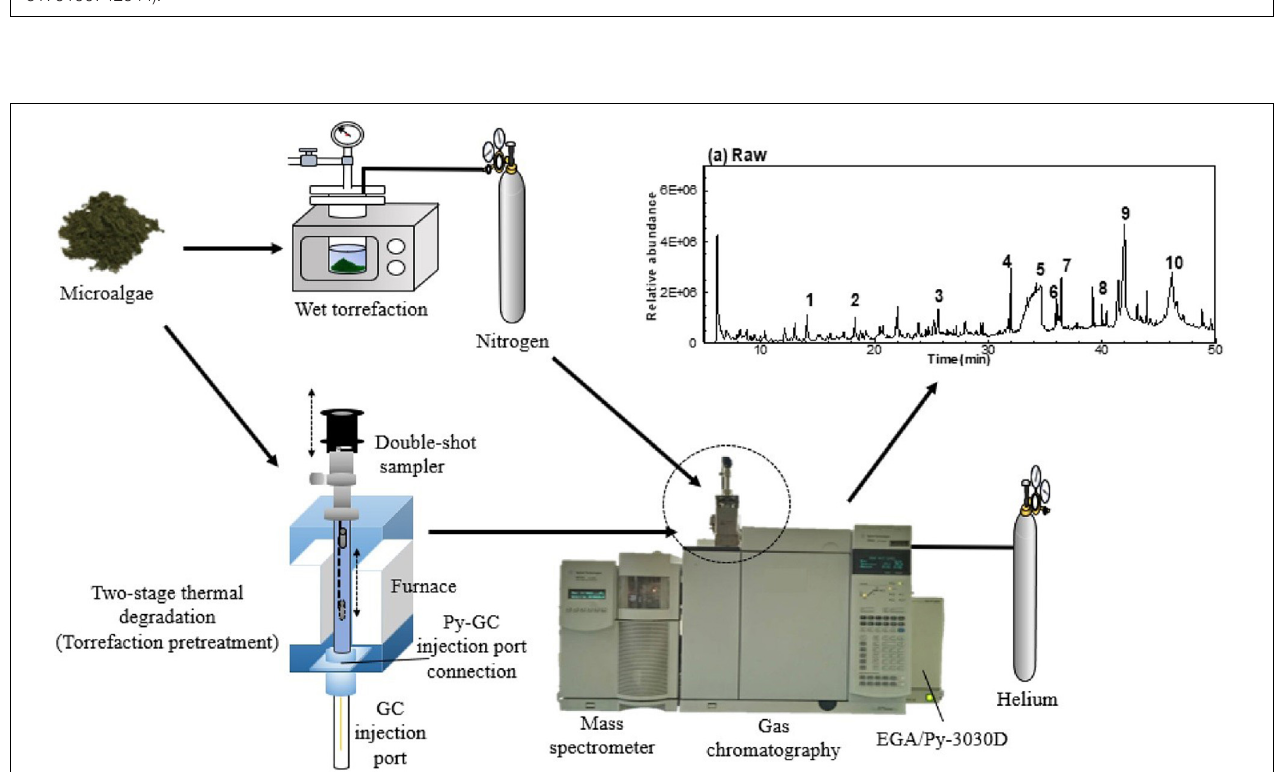
FIGURE 12 | The experiment procedures of GC-MS analysis on wet microalgae and two-stage thermal degradation of microalgae (123) (Copyright permission: 5179191087529).